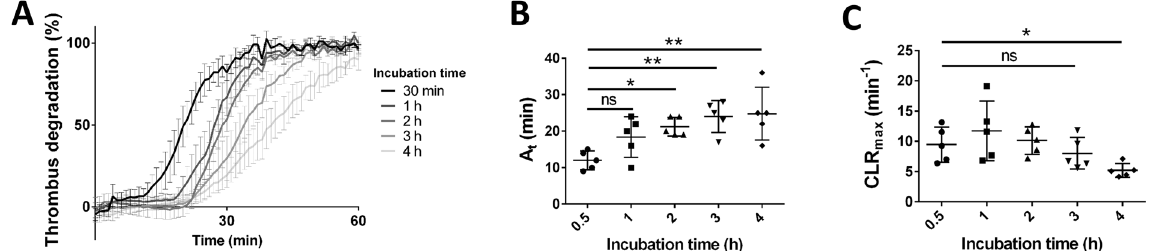
Figure 3. Effect of incubation time. ( A ) Thrombolysis profiles with 200 U/mL urokinase were measured with the Halo assay method on thrombi incubated for 30 min, 1 h, 2 h, 3 h and 4 h. Activation times ( B ) and maximal clot lysis rates ( C ) were presented for each incubation time as mean values ± SD (n = 5, ns: not significant, * p < 0.05, ** p < 0.01).